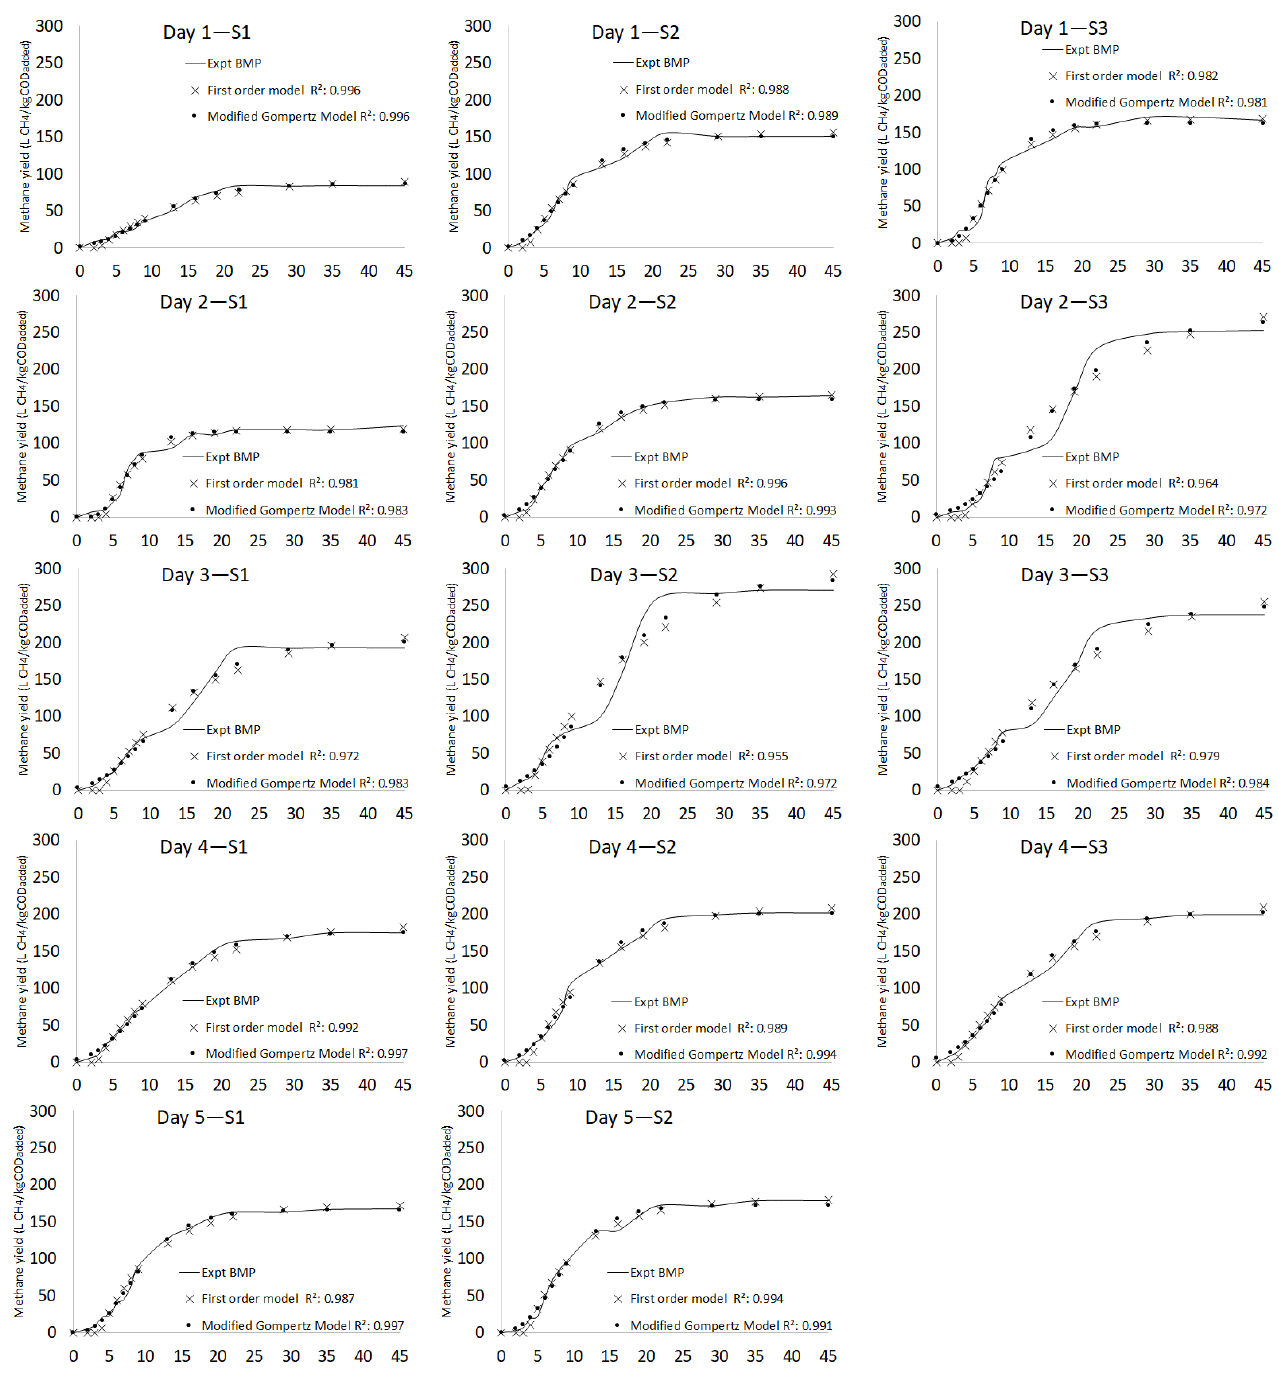
Figure 3. Comparison experimental and modelled data during the anaerobic digestion of rendering wastewater incubated in batch assays at 37 °C.